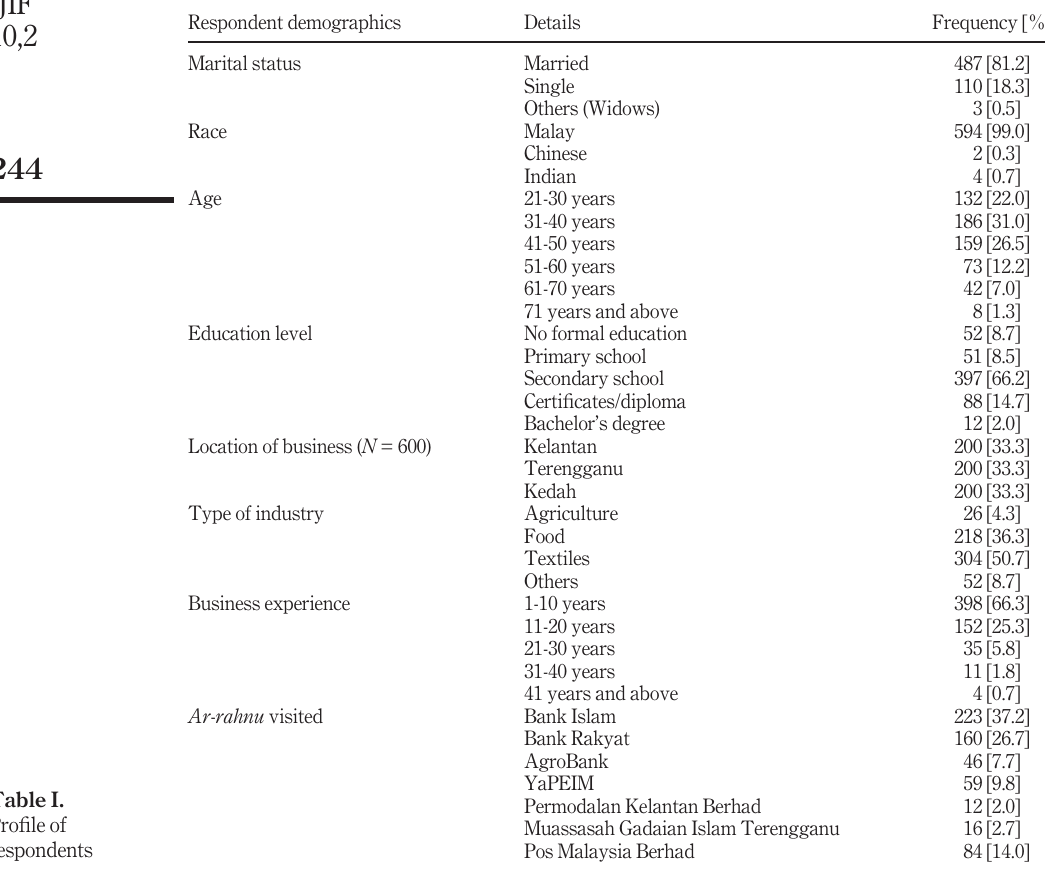
communality values above 0.5. This means that all items have 50 per cent explained a variable ’ s variance. To acquire this variance, a few items need to be deleted. These items are CL1-CL5 (collateral), LC5 (locality), USAGE3 (usage) and USAGE6 (usage). These items are deleted because of having the lowest values for communality, redundant factor loading and also low loading values, below 0.5. These items were thus excluded in Table